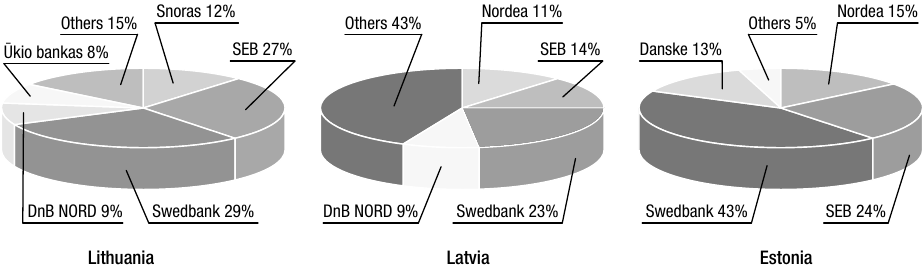
Fig. 3. Division of deposit market shares among the Baltic States banks in 2009* * – “Others” – banks or branches that hold a deposit market share of less than 5 per